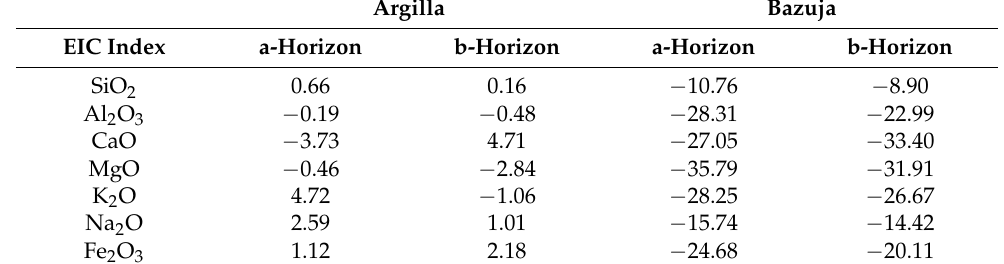
Figure 3. Distribution of calculated EIC SiO 2 compared with EIC Ti in ( a ) and ( b ) soil horizons in the rivers’ Argilla and Bazuja’s catchments. Table 2. Mean EIC values of major elements in soil profiles in river Argilla and river Bazuja.